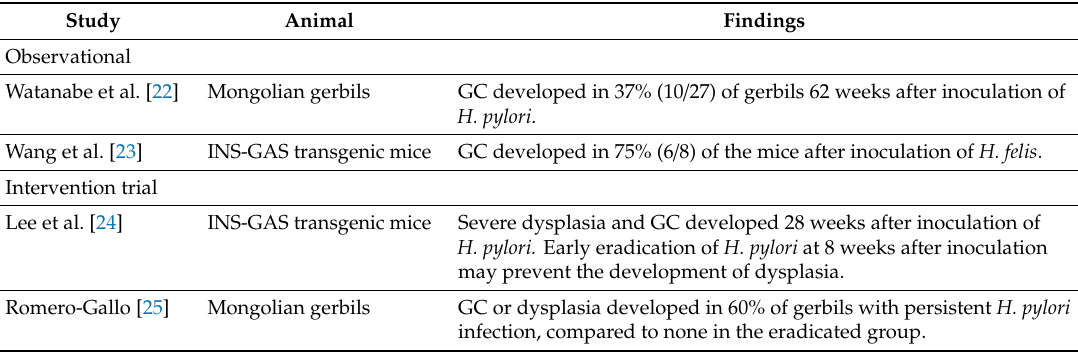
Table 2. H. pylori and gastric cancer risk in animal models.